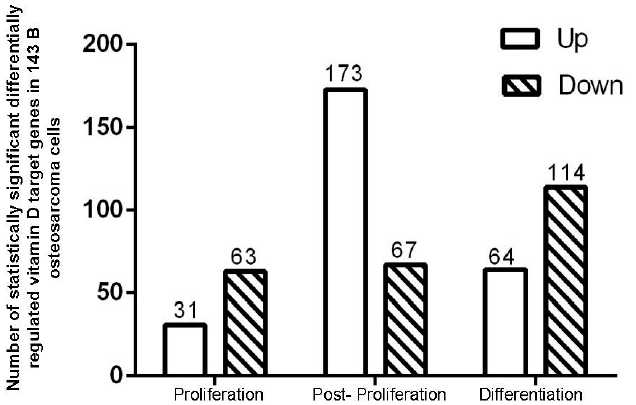
Figure 2. Comparison of number of statistically significant 1 α ,25(OH) 2 D 3 induced target genes in 143B human OS cells during proliferation, post-proliferation, and differentiation relative to control (vehicle).